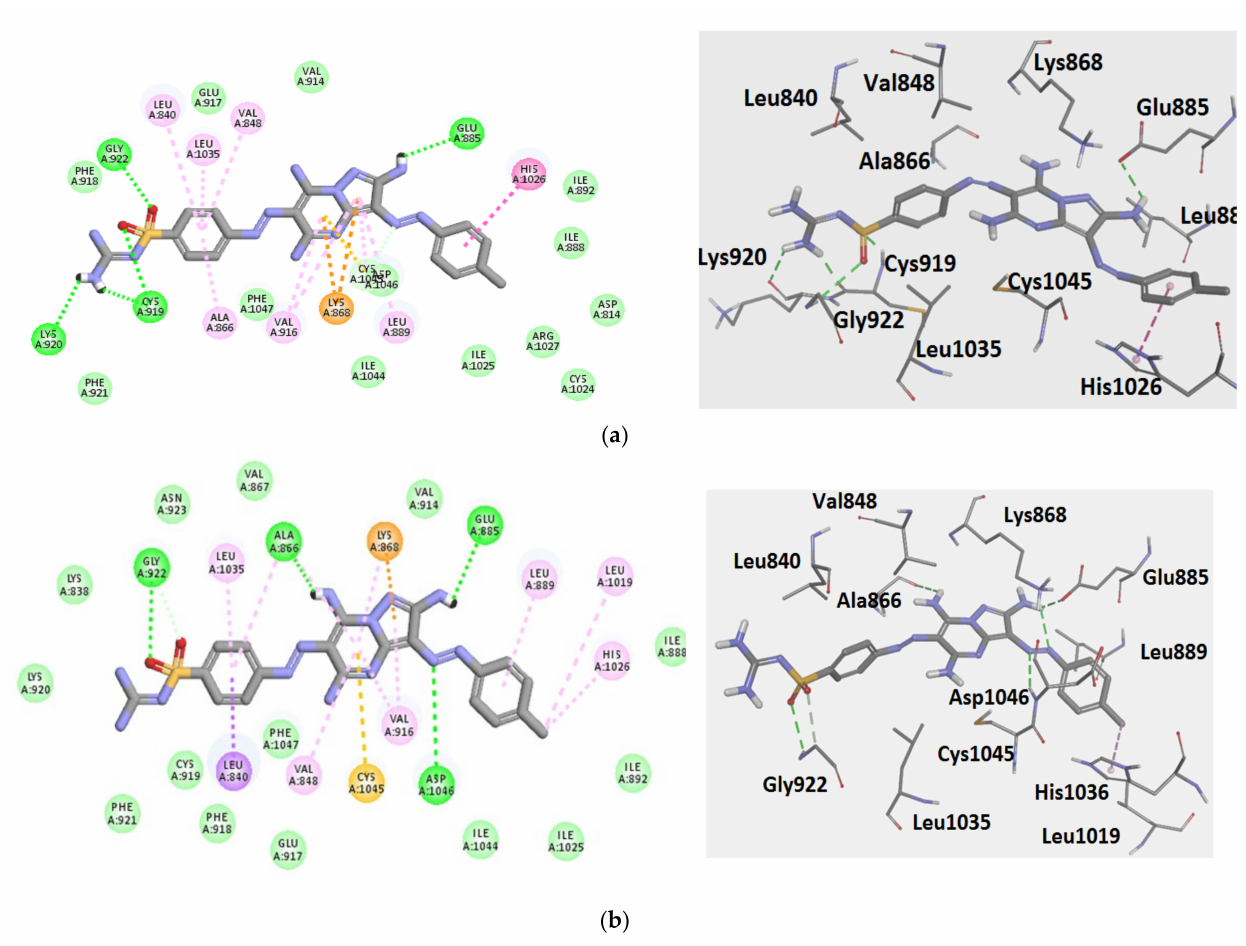
Figure 11. Three-dimensional structural models of compound 7 (( a ): Binding mode A and ( b ): Binding mode B) to VEGFR-2 kinase derived from the docking simulations. Two-dimensional representation of the interacting mode of compounds with VEGFR kinase. The H-bond interactions are represented by dotted